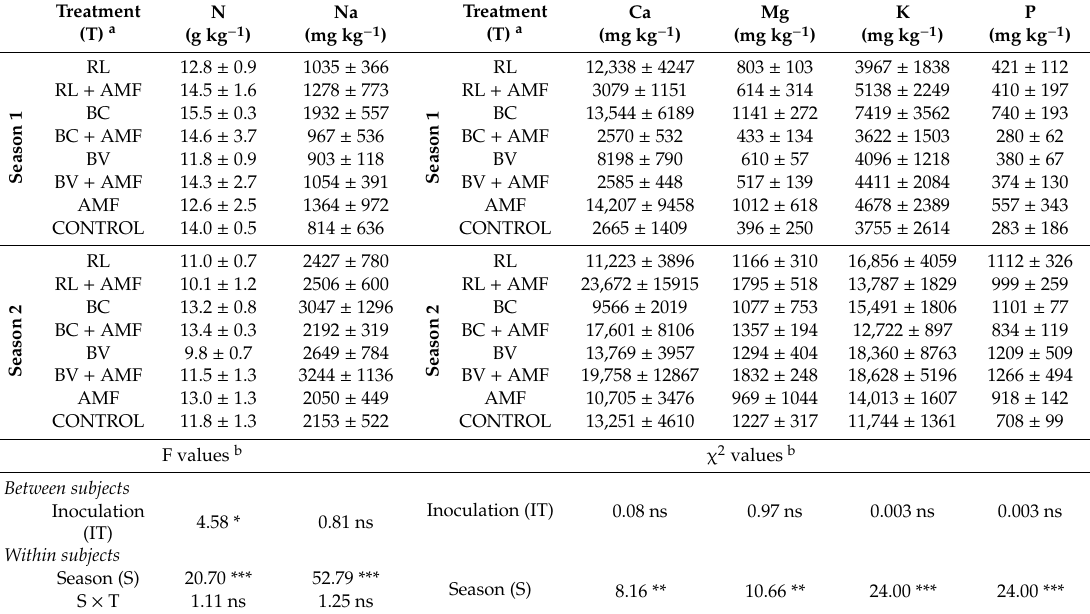
Table 4. Nutrient content of fava bean roots for two consecutive seasons (nitrogen content, calcium, magnesium, sodium, potassium and phosphorus). Values are mean ± standard deviation ( n = 4).